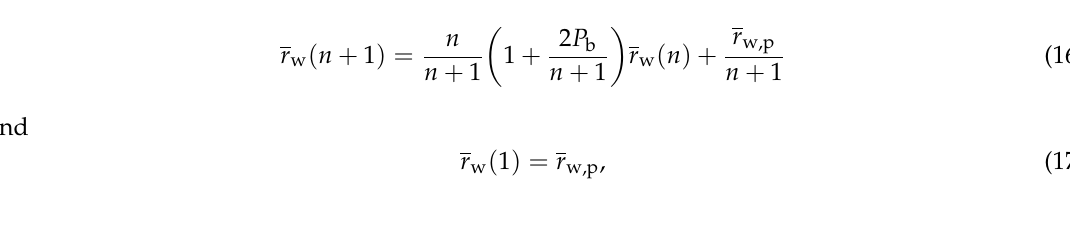
Figure 2. Weight fraction distribution determined by the MC simulation for the conditions, C1–C4. In the figure, PDI means the polydispersity index, defined by PDI = r w / r n . The PDIs are the theoretical values, with r w being calculated from Equations (16) and (17).